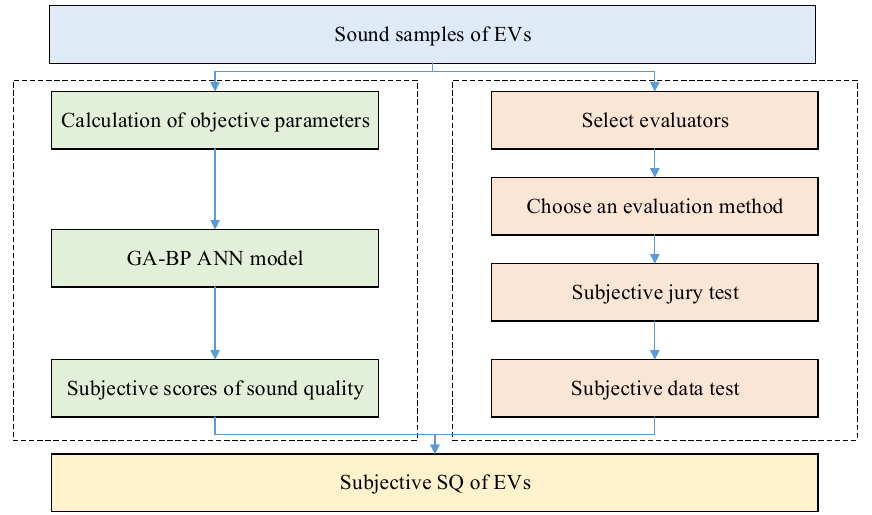
Figure 18. Comparison of the evaluation process of the GA-BP ANN model and the jury test.